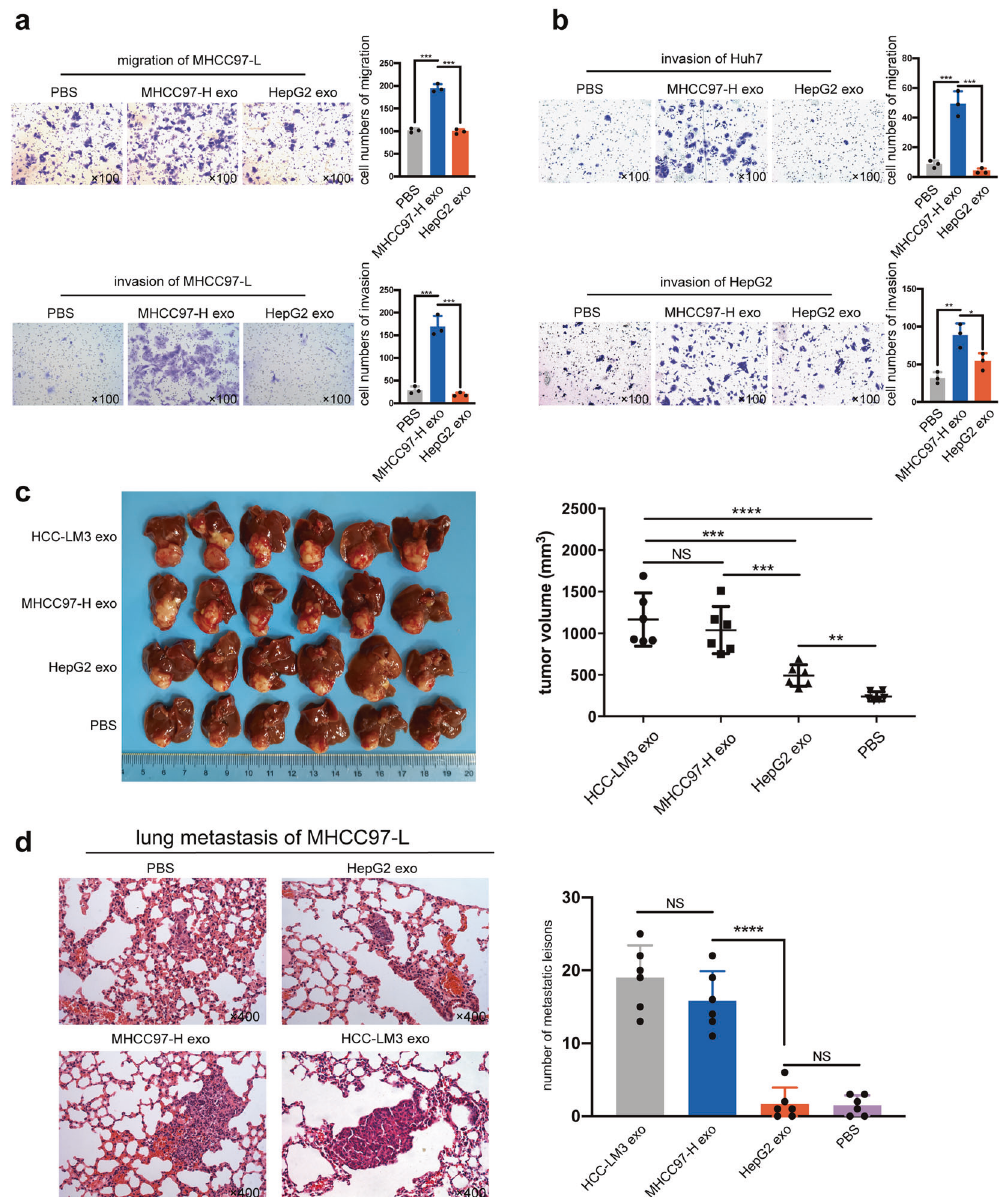
Fig. 2 Highly metastatic HCC cells (HMH) derived exosomes enhance metastatic potential of low metastatic HCC cells (LHM) both in vitro and in vivo. a , b Assessment of migration and invasion in vitro. LHM (MHCC97-L, Huh7, and HepG2) pre-treated with MHCC97-H exosomes, HepG2 exosomes, or PBS (as negative control) for 24 h. The migration ability of MHCC97-L and invasion ability of all the three cell lines were signi fi cantly enhanced by MHCC97-H exosomes compared to the control groups. c Orthotopic implantation liver tumors from nude mice. MHCC97-L cells treated with HMH exosomes (HCC-LM3 exosomes or MHCC97-H exosomes) formed larger liver tumors. d Lung metastasis of mice injected with MHCC97-L. MHCC97-L cells treated with HMH exosomes formed signi fi cantly more lung metastatic lesions. All the in vitro assays were conducted three times with three repetitions. Error bars represent the mean ± SD, and the dots represent the value of repetitions in one experiment; * P < 0.05, ** P < 0.01, *** P < 0.001, **** P < 0.0001, ns: no signi fi cance. An unpaired t test was employed in ( a ) and ( b ), one- way ANOVA followed by Bonferroni ’ s post hoc test was employed in ( c ) and ( d